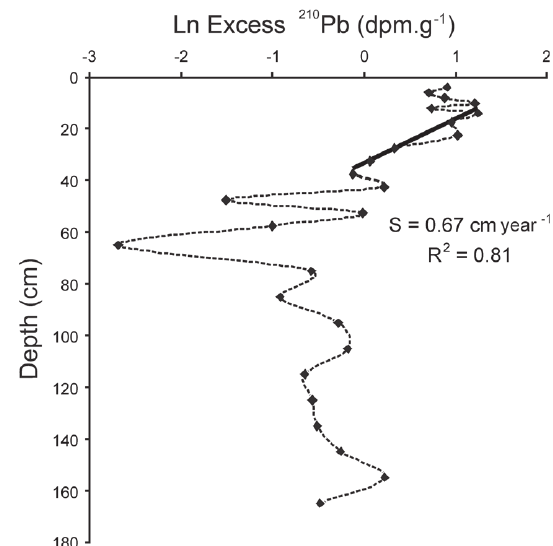
Figure 2 - Percentage of fine sediments in sediment core.